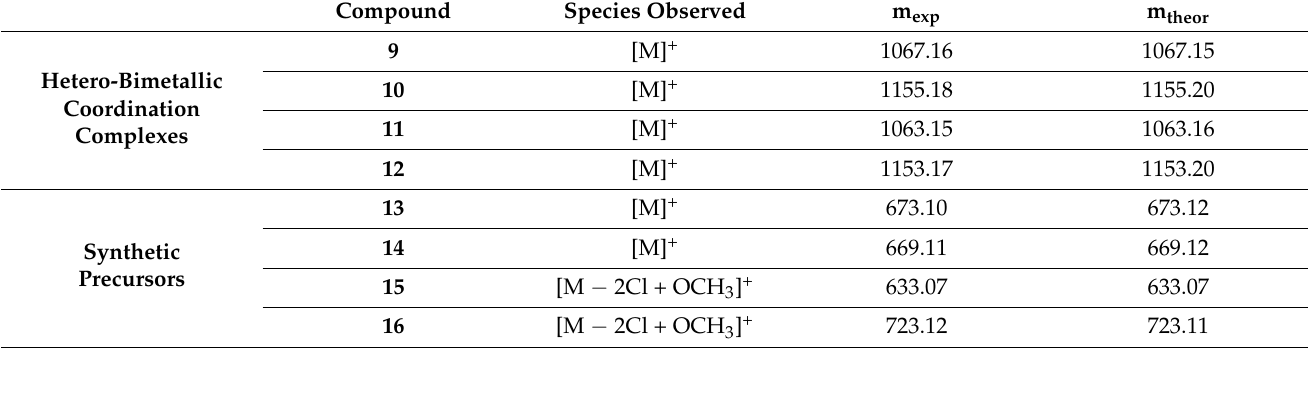
Table 1. Experimental (m exp ) and theoretical (m theor ) m / z mass signals of the investigated compounds.